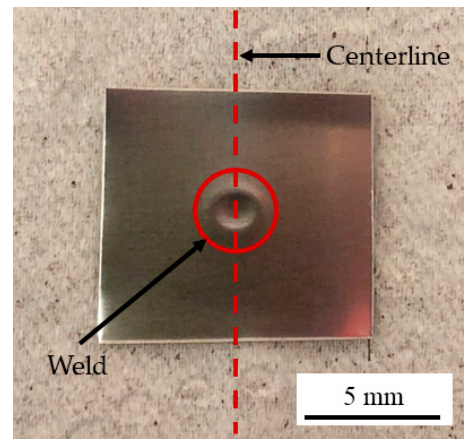
Figure 6. The centerline of the weld.